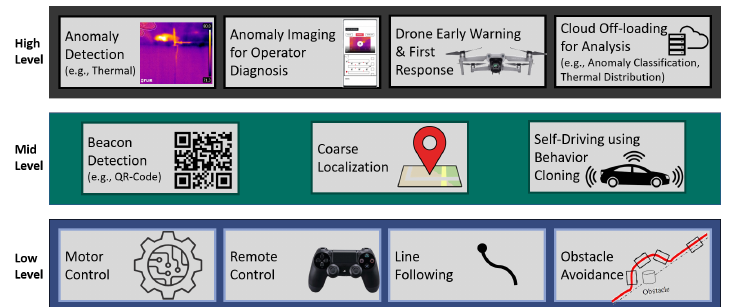
Figure 2. Robot surveyor operating system architecture with modular sub-systems. The architecture is general and adaptable to different applications through the high-level layer.